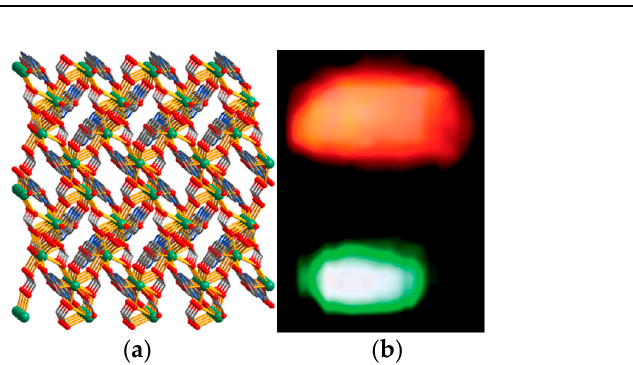
Figure 11. ( a ) 3D metal-organic framework of 53 ; ( b ) temperature-dependent red-orange (top, 298 K) or green (bottom, 77 K) emission under UV excitation. Adapted from [64].